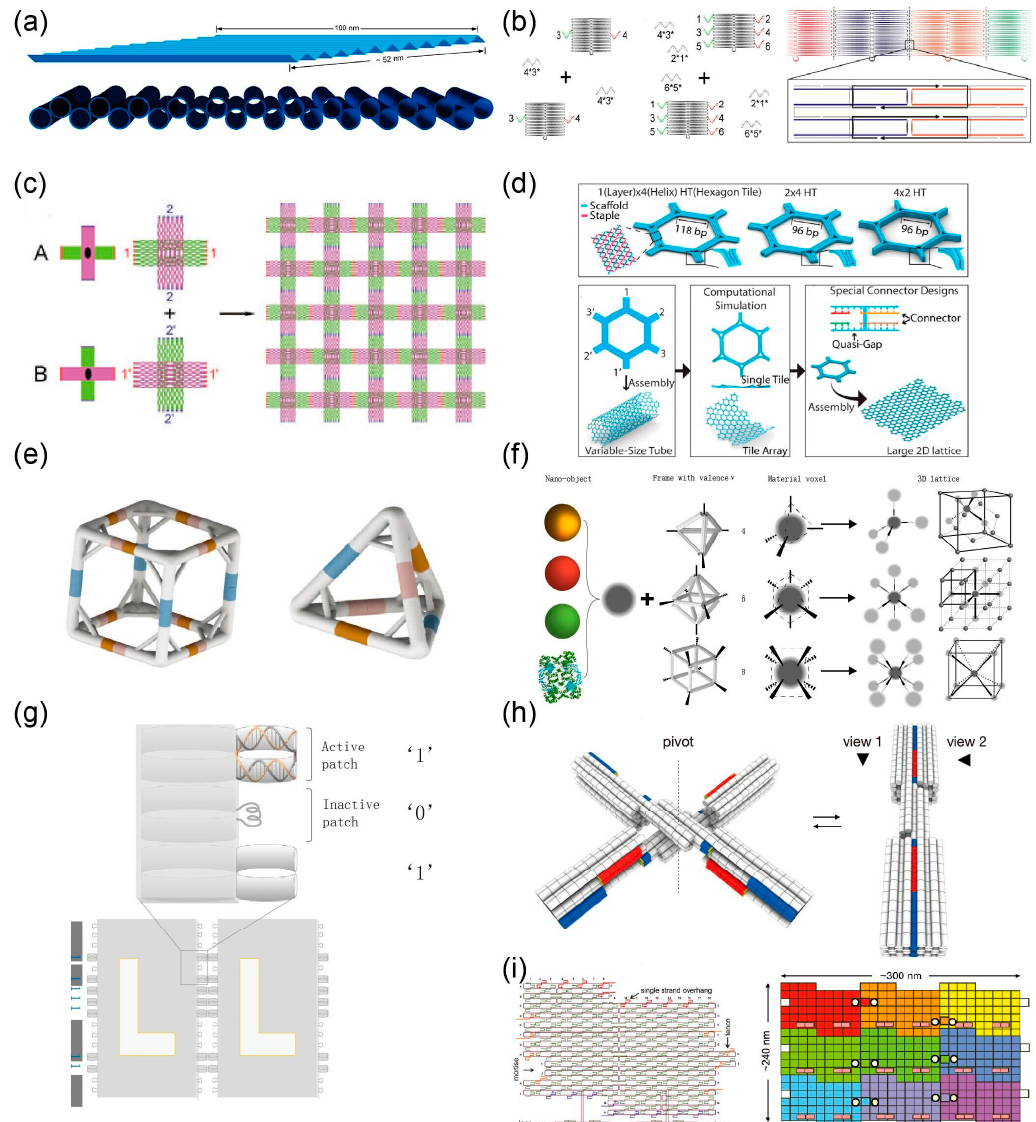
Figure 4. Sticky ends base pairing ( a – f ). ( a ) “Zigzag DNA origami” tiles were assembled into a one-dimensional (1D) lattice. Reproduced with permission of [55]. Copyright American Chemical Society, 2010. ( b ) Three di ff erent assembly methods of DNA origami monomers. Reproduced with permission of [56]. Copyright Springer Nature, 2011. ( c ) Assembly of a 2D DNA origami lattice using a cross-shaped origami tile. Reproduced with permission of [57]. Copyright WILEY − VCH Verlag GmbH & Co. KGaA, Weinheim, Germany, 2011. ( d ) Programming DNA origami honeycomb 2D lattices. Reproduced with permission of [58]. Copyright American Chemical Society, 2016. ( e ) A polyhedron self-assembled from DNA tripods. Reproduced from [59]. ( f ) Constructing di ff erent 3D DNA origami lattices using DNA-prescribed and valence-controlled material voxels. Reproduced with permission of [2]. Copyright Springer Nature, 2020. Blunt ends base stacking ( g – i ). ( g ) Recognition based on the binary sequences of blunt ends and the complementarity of the origami edge shapes of DNA nanostructures. Reproduced with permission of [60]. Copyright Springer Nature, 2011. ( h ) Self-assembly of 3D DNA components in a solution on the basis of shape complementarity. Reproduced from [61]. ( i ) Assembly of multiple DNA origami jigsaw pieces in three different ways. Reproduced with permission of [62]. Copyright American Chemical Society, 2011.